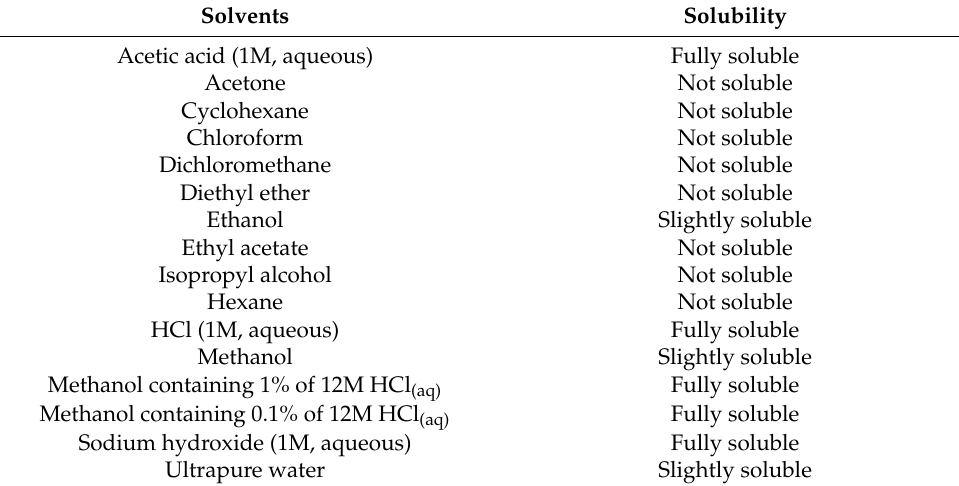
Table 1. Qualitative estimation of PF solubility 1 , data from [17].